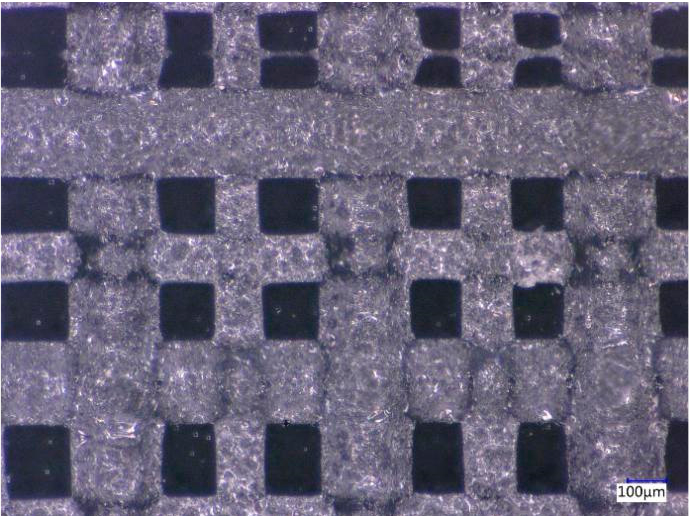
Figure 17. Morphology of c ruciform secondary microstructures on PMMA surface.